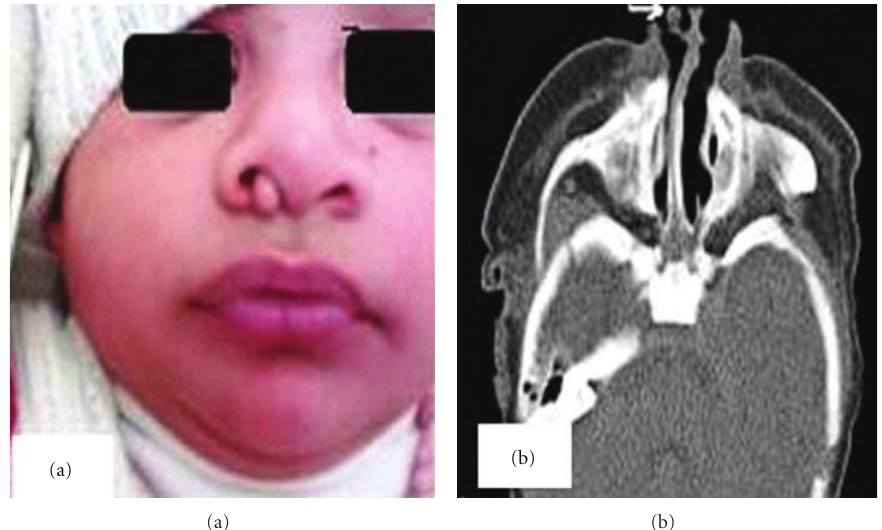
Figure 1: (a) 3 months old baby with right nasal congenital polyp-glioma. (b) Axial CT scan revealing a soft tissue lesion arising from nasal septum (white